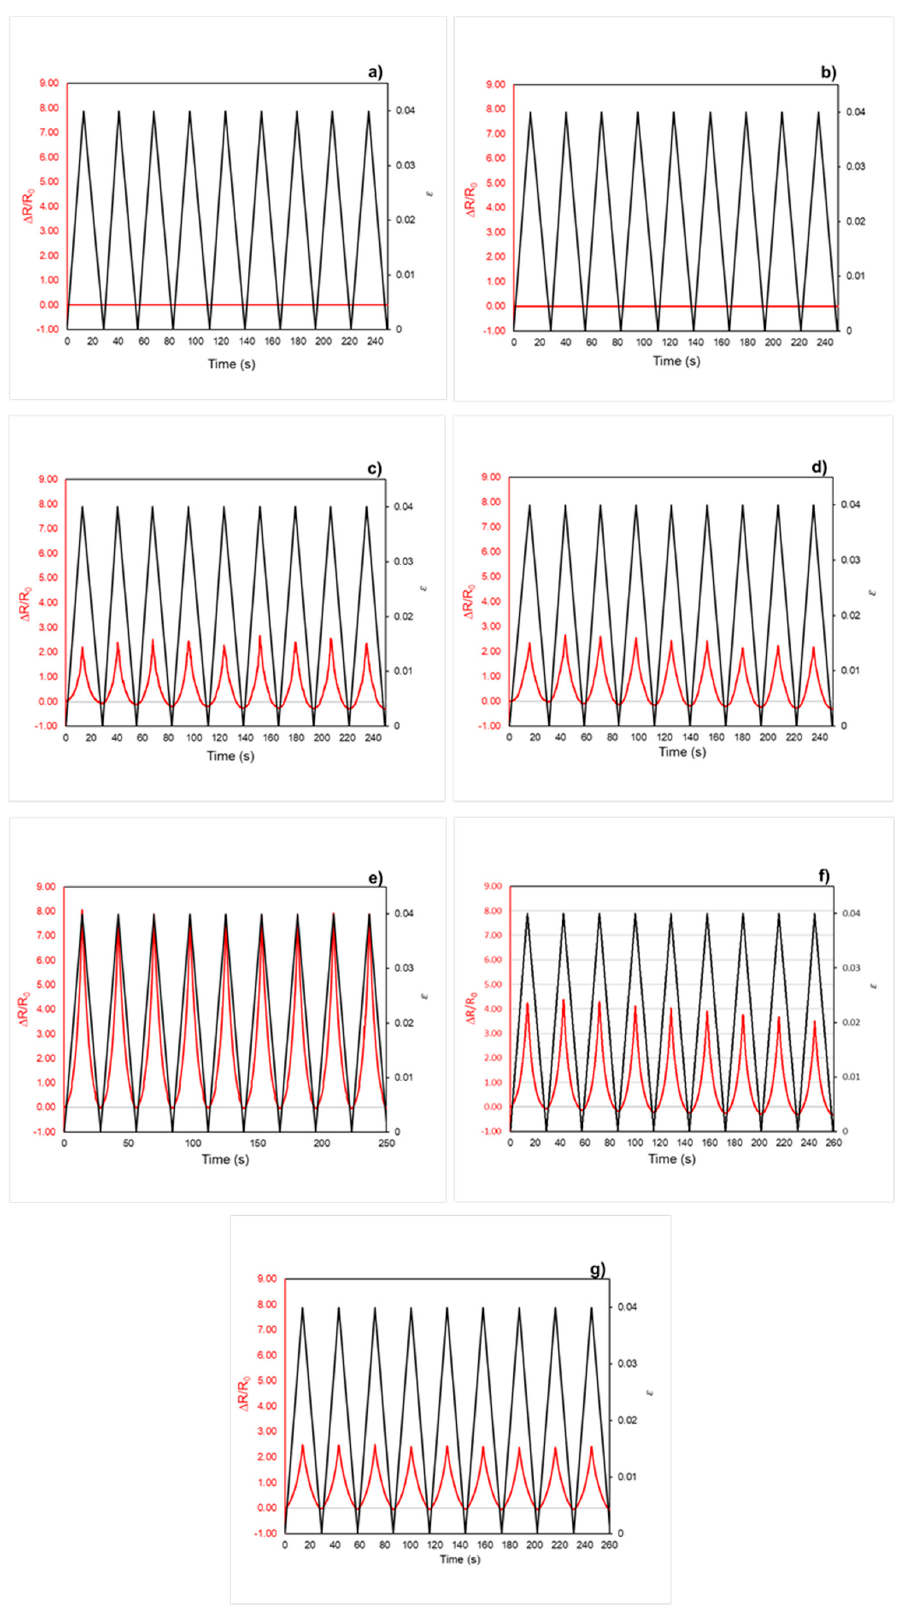
Figure 10. Piezoresistive response of PCL membrane ( a ), 0.05%GNPs-PCL membrane ( b ), 0.1%GNPs-PCL membrane ( c ), 0.2%GNPs-PCL membrane ( d ), 0.5%GNPs-PCL membrane ( e ), 1%GNPs-PCL membrane ( f ), and 2%GNPs-PCL membrane ( g